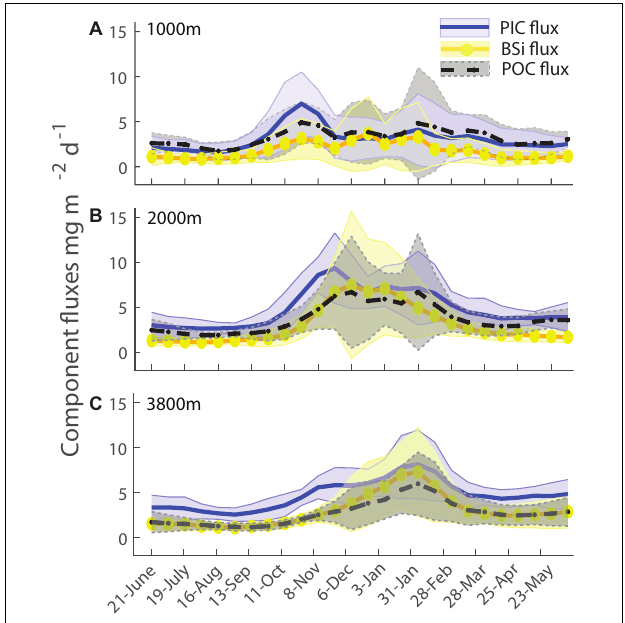
FIGURE 8 | Seasonal component flux variations at each depth: (A) 1000 m, (B) 2000 m, (C) 3800 m. Lines show average values; shaded envelopes show 1